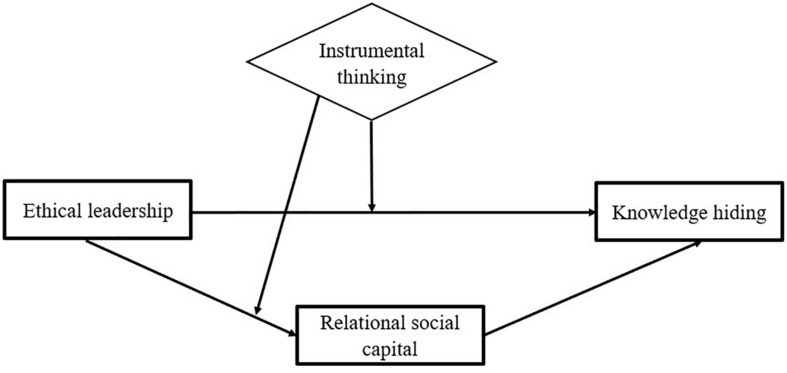
The proposed model.